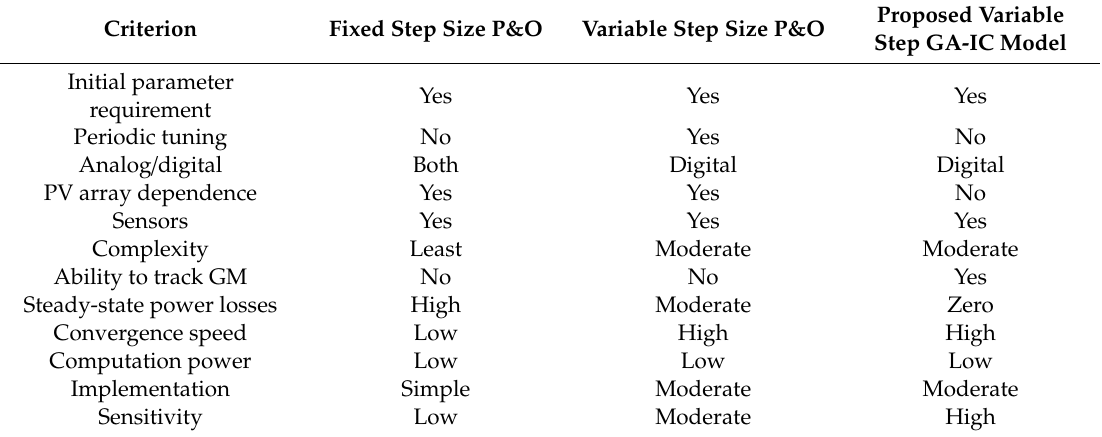
Table 8. Qualitative analysis of MPPT technique for a variable step